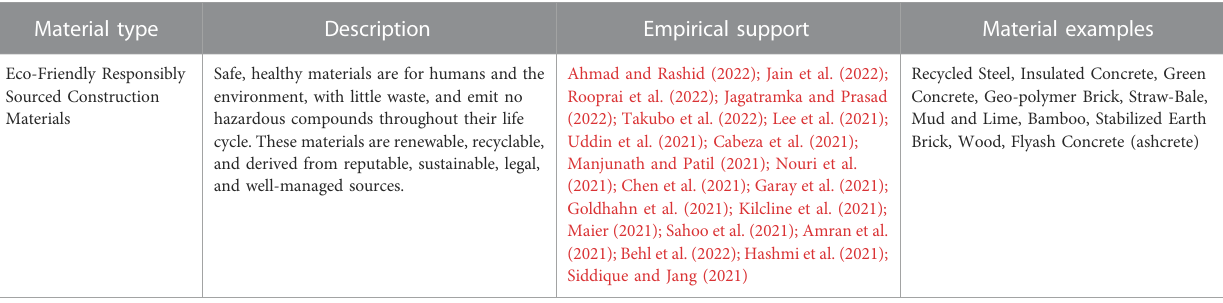
TABLE 2 Eco-friendly building